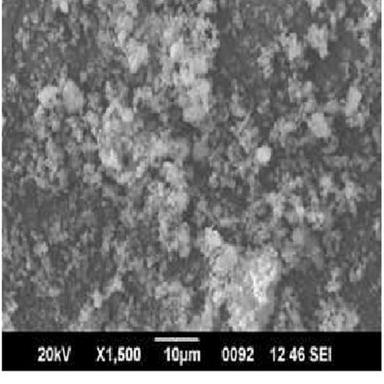
SEM images at (i) resolution of x1500 and (ii) at resolution of 500 for RbCl doped MgO nanomaterial.